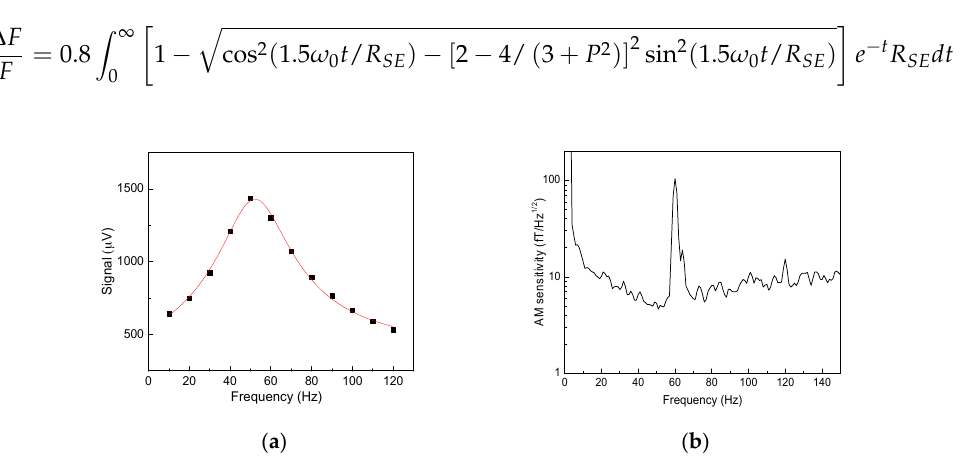
Figure 2. ( a ) The frequency profile of the AM response fit with Expression (2); ( b ) The sensitivity of the AM when it is tuned to 50 Hz with a bias field; the frequency response ( a ) is used to convert AM noise spectrum to sensitivity.